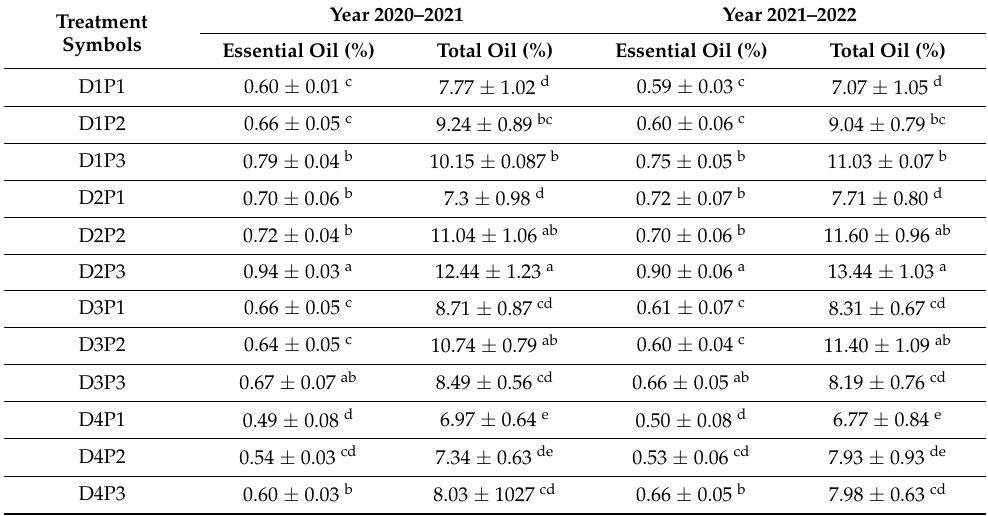
Table 2. Effect of date of sowing and spacing of plants on essential oil and total oil contents of Treatment Data are the average of three replicates ± SD of individual treatments of the field experiment; grouping information between the mean values of the obtained data was carried out by Tukey’s test and 95% confidence ( p ≤ 0.05). Values with different lowercase letters within columns are statistically significantly different according to Tukey’s test for α =